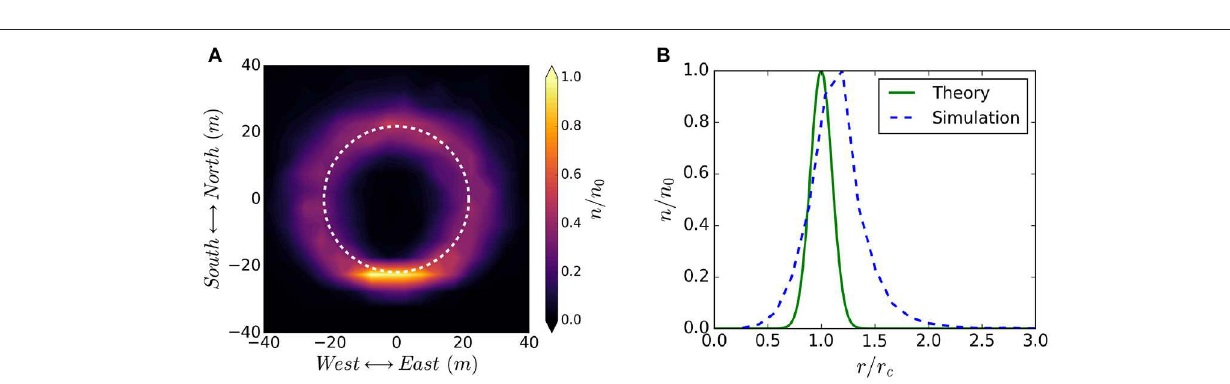
FIGURE 13 | (A) Normalized electron density distribution at impact with the Earth, the theoretically predicted cyclotron radius from Equation (14) is overlayed as a dashed white line. (B) Normalized radial electron density distribution compared with theoretical predictions for beam cyclotron radius (distribution mean) and final beam envelope RMS radius (distribution spread). An animation of beam particle evolution from injection until impact with the atmosphere for these results can be viewed here: